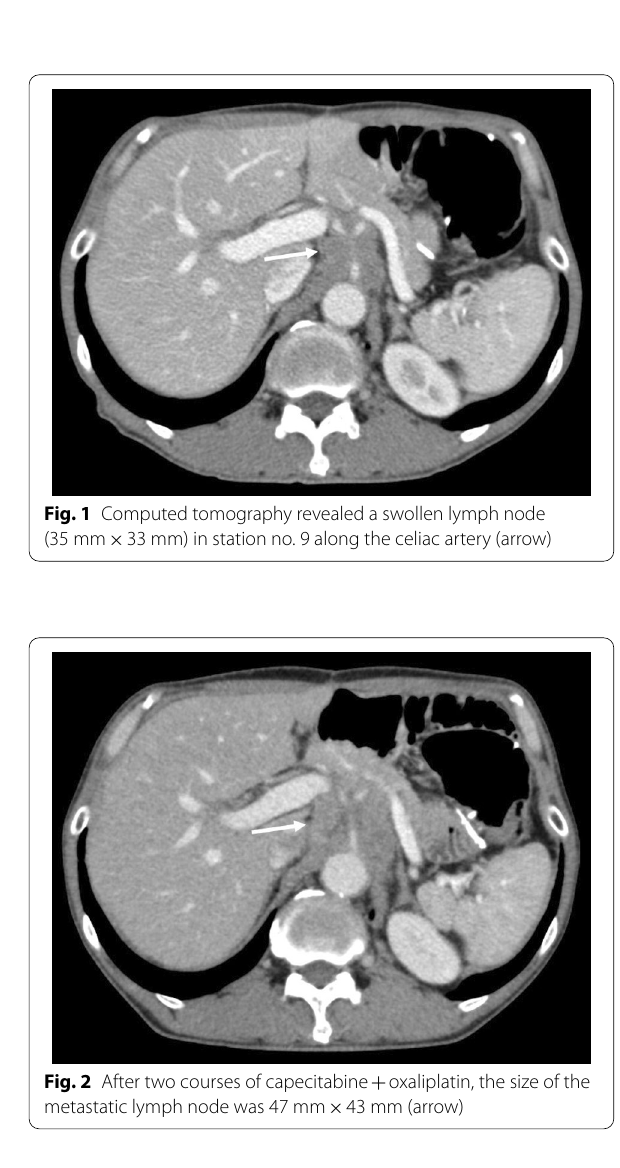
oxaliplatin, the size of the + 43 mm ×